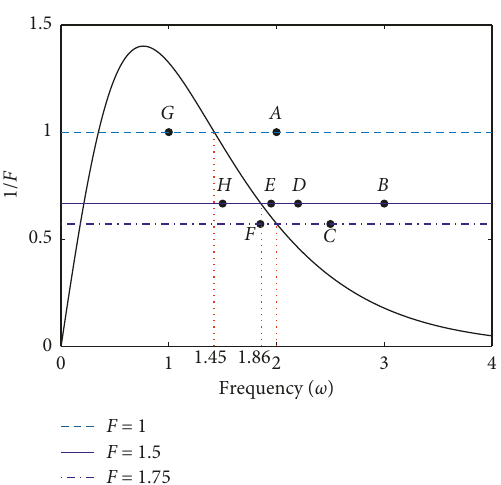
Figure 4: Chaotic threshold curve and the location of each point.